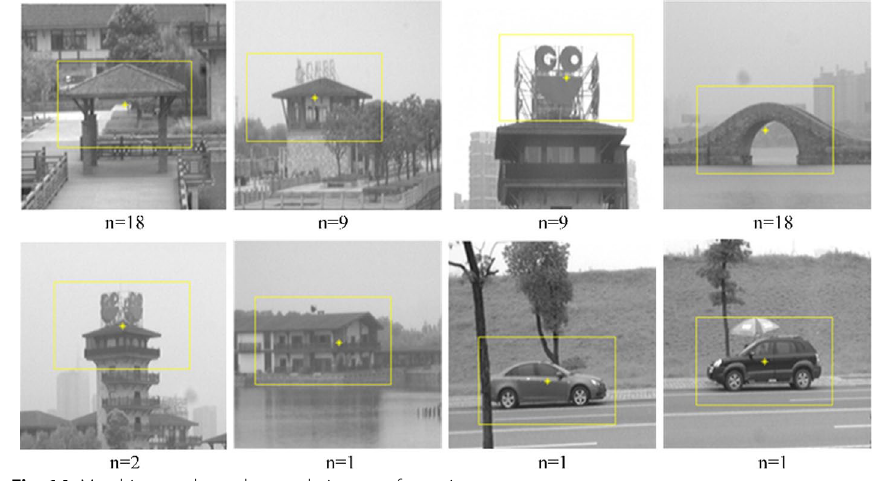
Fig. 14 Matching results under translation transformation